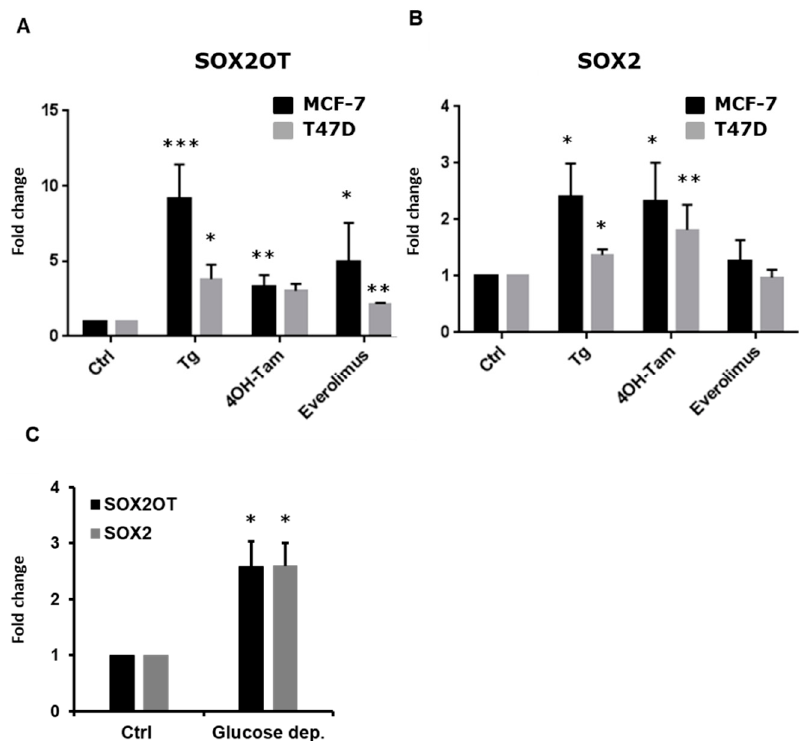
Figure 4. Expression of SOX2OT and SOX2 following UPR induction in ER+ breast cancer cell lines. MCF-7 and T47D cells were incubated in a control medium (Ctrl) or in a medium containing the ER stress-inducing agents thapsigargin (Tg, 300 nM), 4OH-Tam (0.1 µM), or everolimus (10 nM) for 16 h. ( A , B ): The effects of Tg, 4OH-Tam, and everolimus on the expression of SOX2OT and SOX2 were measured by RT-qPCR and are relative to the housekeeping genes HPRT and GAPDH . ( C ): MCF-7 cells were cultivated in media containing 25 mM glucose (Ctrl) or lacking glucose (Glucose dep) for 48h. The expression of SOX2OT and SOX2 was measured by RT-qPCR and is relative to HPRT and GAPDH . Error bars represent standard deviations of at least 3 independent experiments. * p < 0.05, ** p < 0.01, *** p < 0.001.